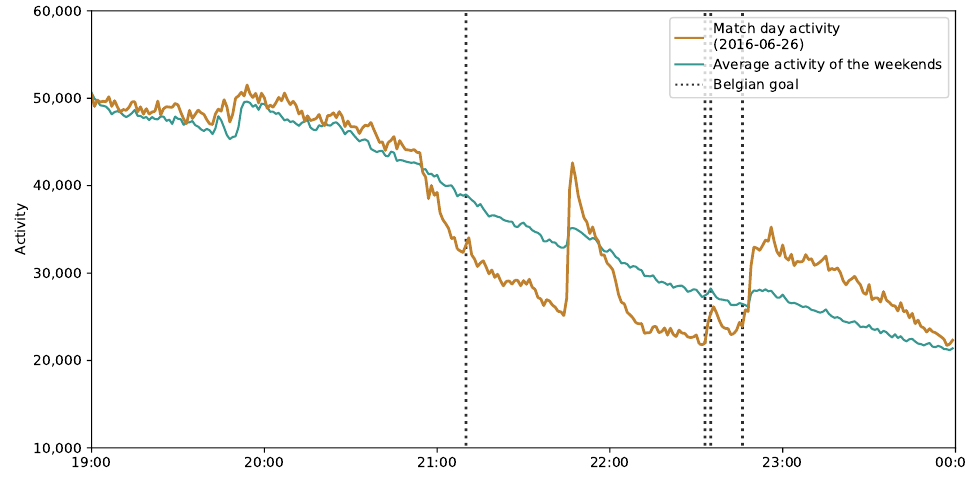
Figure 17. Mobile phone activity during and after the Hungary–Belgium Euro 2016 match in com- parison with the average activity of the